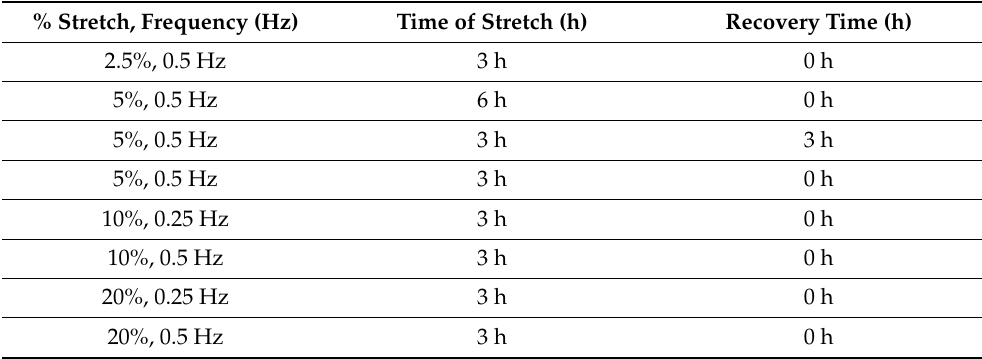
Figure 2. Peripheral nervous system (PNS) and central nervous system (CNS) nerve-dorsal root ganglia (DRG) explants. ( A ) The L4-L5 DRG are either connected to the sciatic nerve or continue independently along their dorsal roots into the spinal column. Two groups were prepared with either the central nerves connected to their respective L4/L5 DRG or the sciatic nerve connected to the L4/L5 DRG. ( B ) Explant nerves were glued on two PEEK bars facing towards each other, with the DRG sitting on one bar and the end of the nerve(s) seated on the other bar with a 1 cm distance between them. With the 10% cyclic movement of plate B (lower metal plate), 1 mm dislocation was achieved. Table 1. Stretch parameters